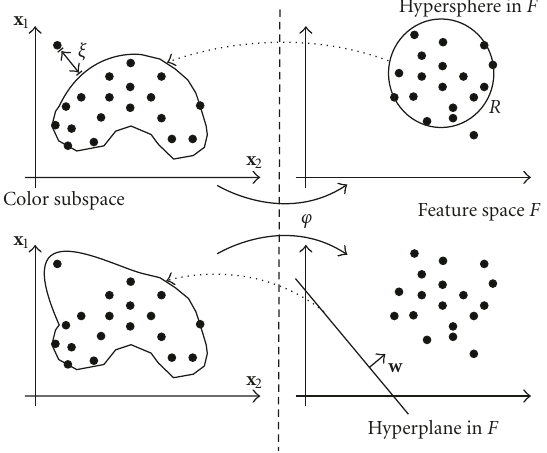
Figure 1: SVND algorithms make a nonlinear mapping from the input space to the feature space. A simple geometric figure (hypersphere or hyperplane) is traced therein, which splits the feature space into known domain and unknown domain. This corresponds to a nonlinear, complex geometry boundary in the input